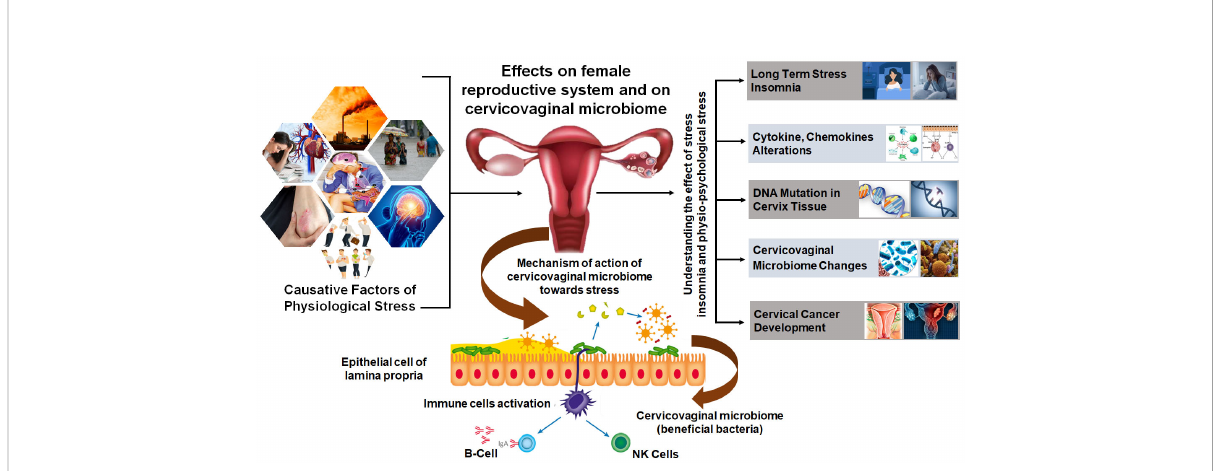
FIGURE 3 Comprehensive summary of stress responses and risk factors affecting cervical physiology and cancer development. Different causative factors impacting negative consequences of the physiological stress on female reproductive system which ultimately lead to modulating DNA integrity, inducing in fl ammatory cytokines and chemokines pro fi le, and altering the cervicovaginal microbiota, and consequently causes the development of cervix lesions and cervical